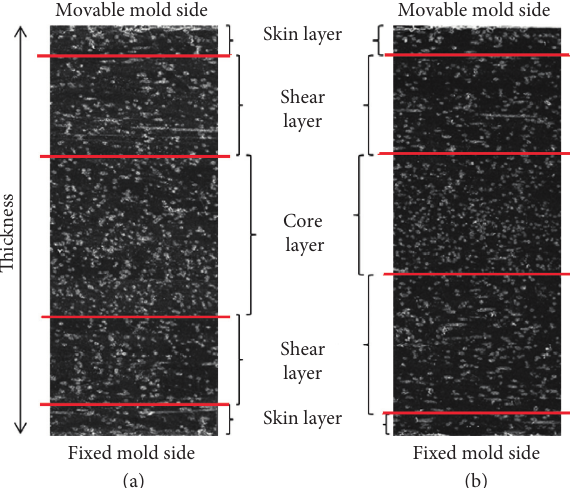
Figure 3: SEM micrographs of inner multilayer thickness distribution. Trend of tested samples: (a) CIM sample; (b) RHCM